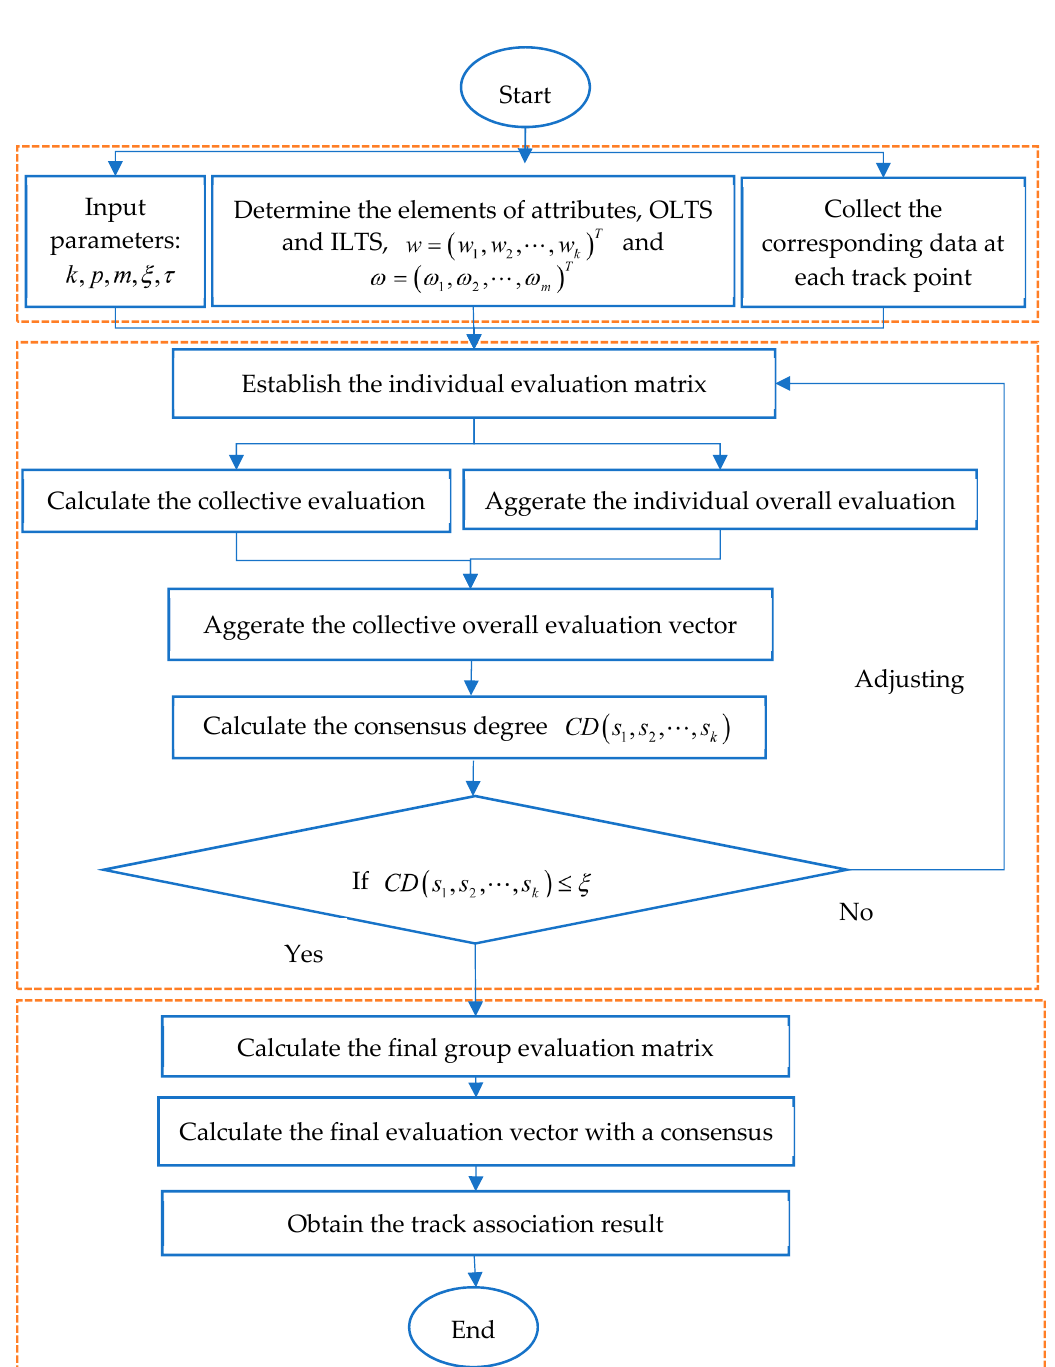
Figure 1. The flowchart of the track association algorithm based on the consensus model with nested probabilistic-numerical linguistic term sets